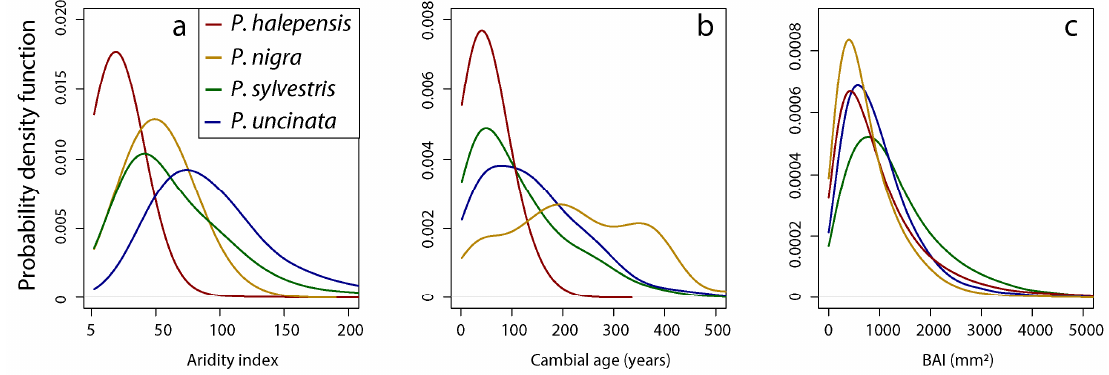
Figure 2. Density distribution of tree-rings with regards to ( a ) their distribution in different aridity conditions, ( b ) their cambial age, and ( c ) the basal area increment that they represent.